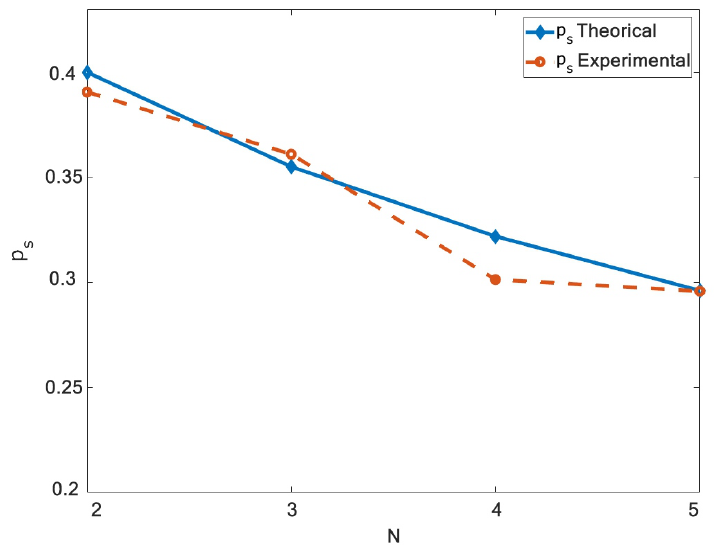
Figure 9. Probability of success p s , including the probability of jamming p j , is plotted with repect to N . A good agreement exists between the experimental and proposed theoretical